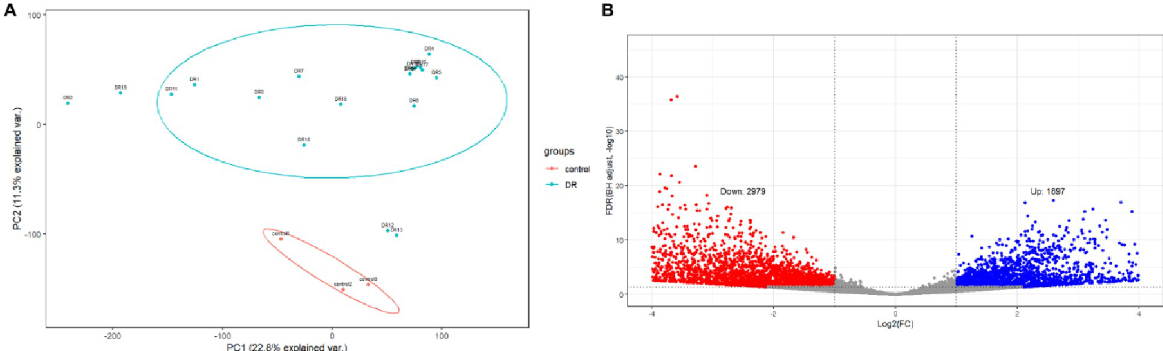
Fig 1. DEGs in DR and control samples. (A) PCA for GSE102485. Red, control; Green, DR. (B) Volcano of the 4876 DEGs. Red, up-regulation; Blue